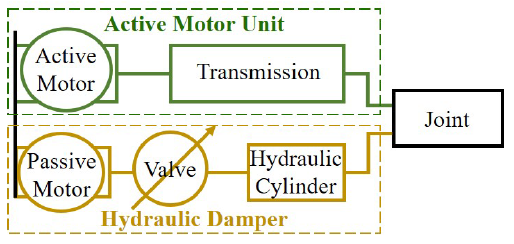
Figure 1. Conceptual depiction of the hybrid passive–active knee